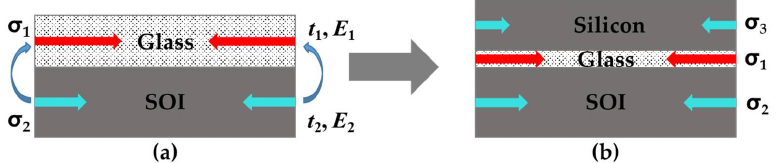
Figure 2. Schematic of multi-layer structures: the SOI wafer bonded with ( a ) the pure glass cap and ( b ) the SOG cap. Table 1. Properties of materials used in finite element method.